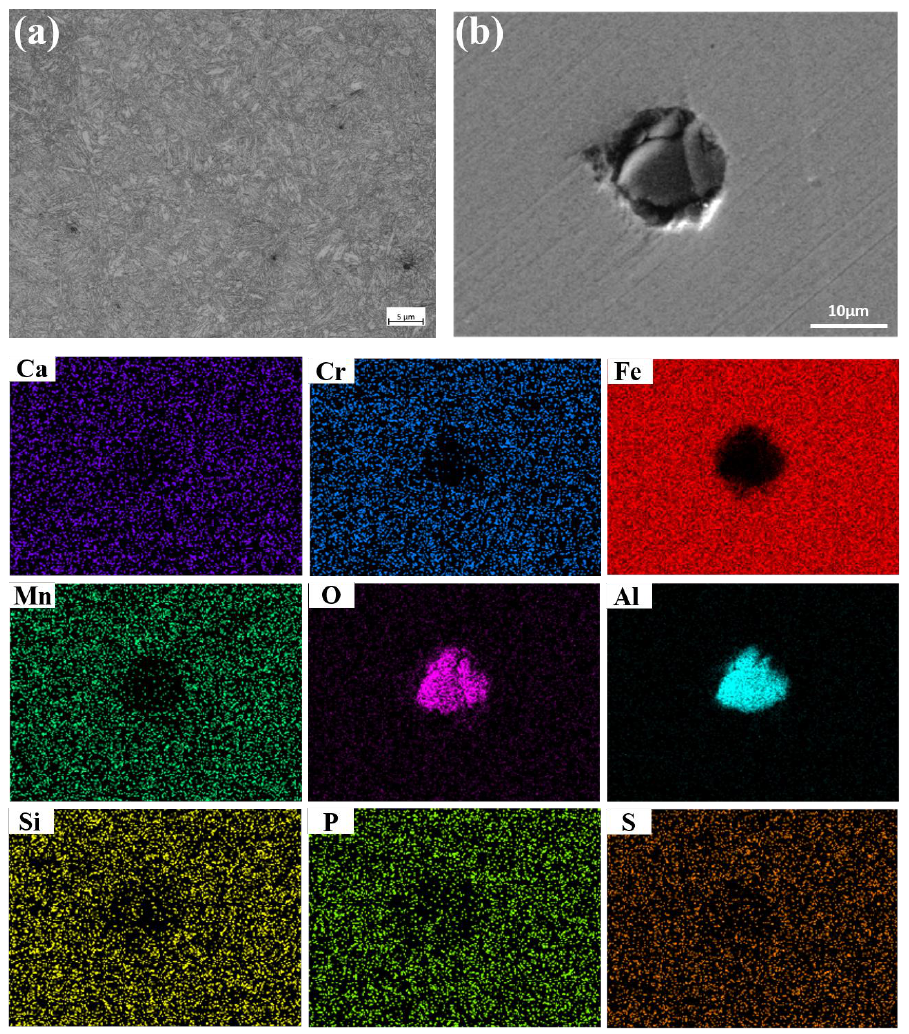
Figure 2. Metallographic structure and non-metallic inclusion of failed tubing. ( a ): Metallographic structure; ( b ): non-metallic inclusion.